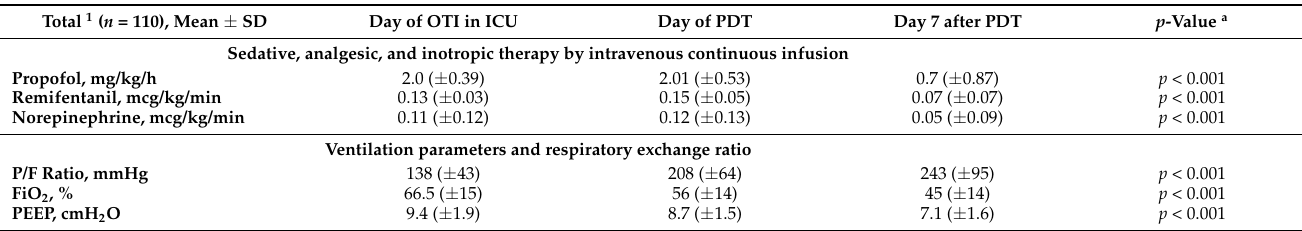
Table 2. Characteristics of laboratory, ventilation, and infusion therapy